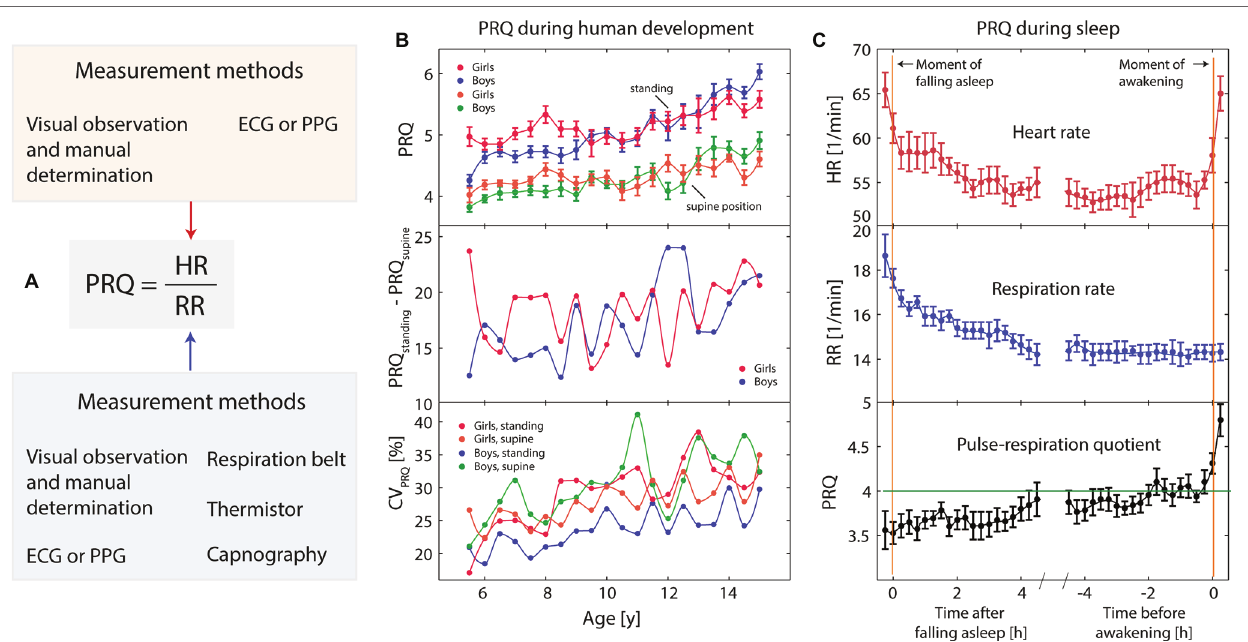
FIGURE 2 | (A) Visualization of the main methods of measuring the pulse-respiration quotient (PRQ). (B) PRQ during human development [ n = 1,820, age range: 5.5–15 years, daily resting-state PRQ (D-rs-PRQ) measurements] as a function of age, sex, and body position (data extracted from Matthiolius and Hildebrandt, 1995). CV: coefficient of variation, error bars: standard error of the mean. (C) Typical changes of heart rate (HR), respiration rate (RR), and PRQ during sleeping (data extracted from Pöllmann and Hildebrandt, 1970; n = 7). The PRQ normalization tendency during sleep (especially during the last hours before awakening) is clearly visible. Error bars: standard error of the